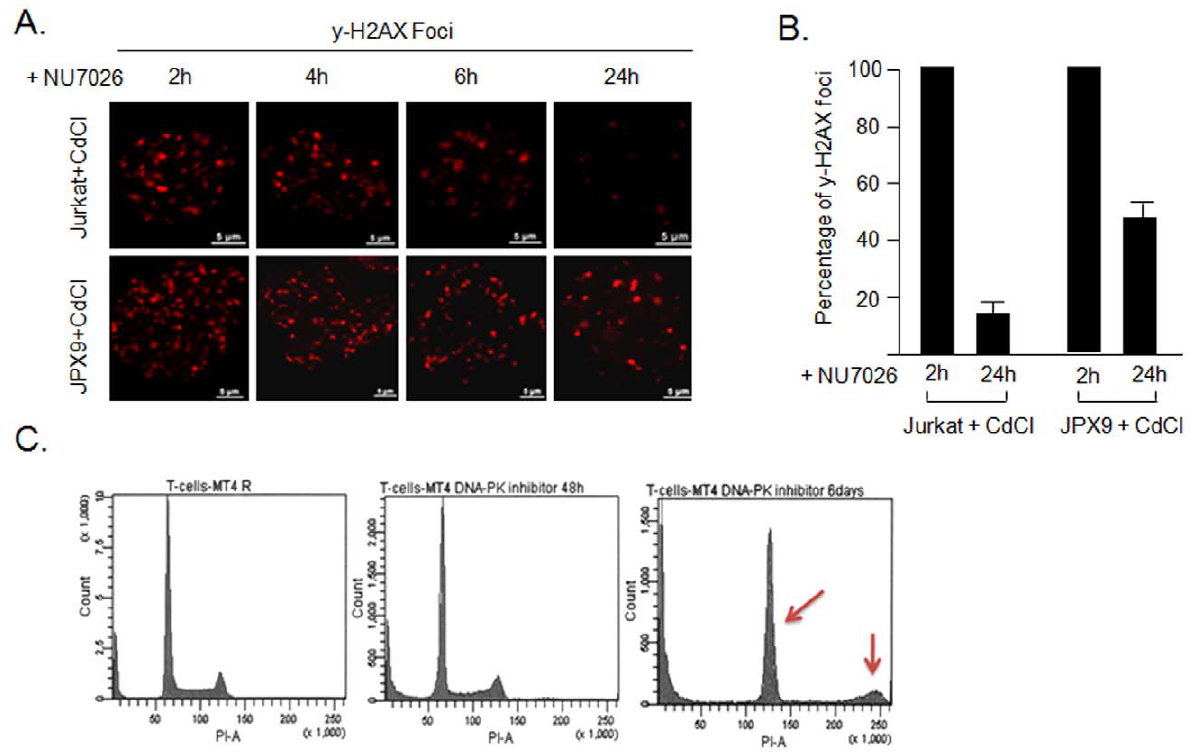
Figure 5. Tax-associated DDSB are not repaired by SSA or MMEJ. A and B) Tax-inducible cell line JPX9 and Jurkat control cells were induced with CdCl, c -irradiated with a dose of 2Gy and treated with or without DNA-PK inhibitor NU7026. c H2AX foci were detected by microscopy at time t=0, 2 h, 4 h, 6 h and 24 h. Image results provided are representative of the experiment performed in duplicate. Average number of c -H2AX foci per cell was quantified by microscopy. The error bars in the figures represent the standard error of the mean (SEM) for 30 to 50 cells per sample. The images were obtained using epifluorescence Nikon Ti-s and have been treated with the deconvolution feature provided with the Nikon’s NIS-Element software. C) HTLV-I Tax-expressing cells MT-4 were untreated (left) or incubated with DNA-PK inhibitor for 2 days (middle panel) or 6 days (inhibitor was replenished every 2 days). Cell cycle was analyzed by FACS after propidium iodide staining. Arrows indicate cell cycle arrest in G2/M and aneuploidy.